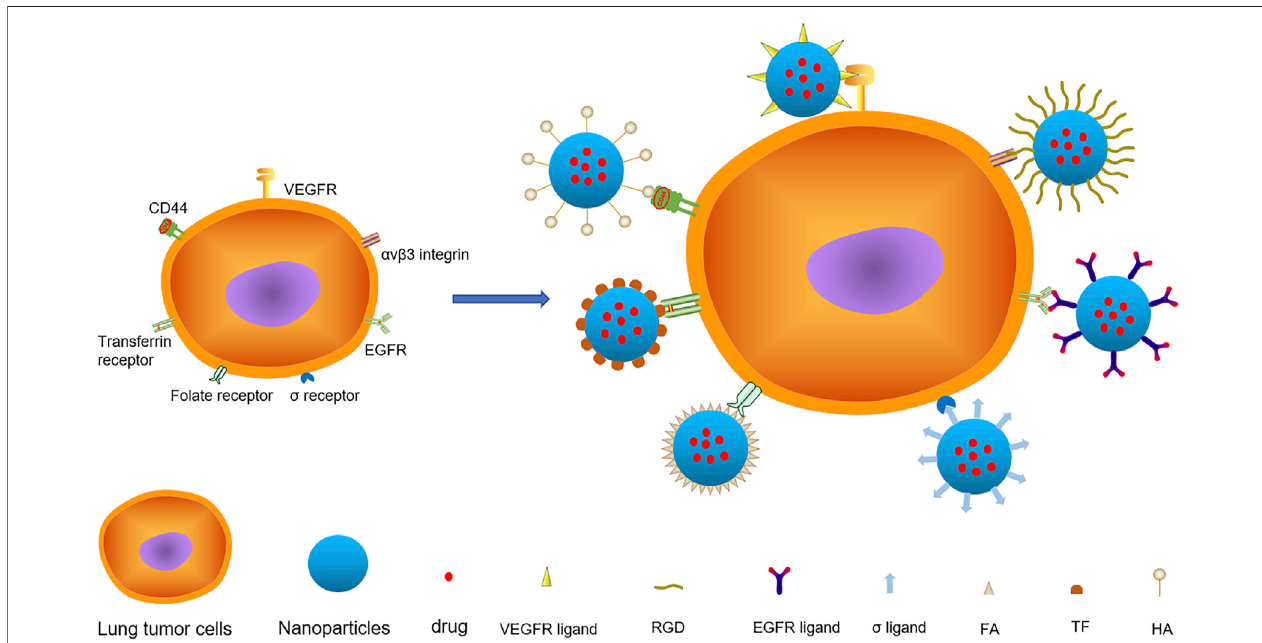
FIGURE 1 | There are various targets on lung cancer cells, among which VEGFR, α v β 3 Integrin, EGFR, σ Receptor, Folate Receptor, Transferrin Receptor and CD44 areimportant targets. Thenanoparticleswithspeci fi cligandstructure loaded withanticancer drugsspeci fi cally bindtothereceptors onthesurfaceoflung cancer and deliver the drugs to the